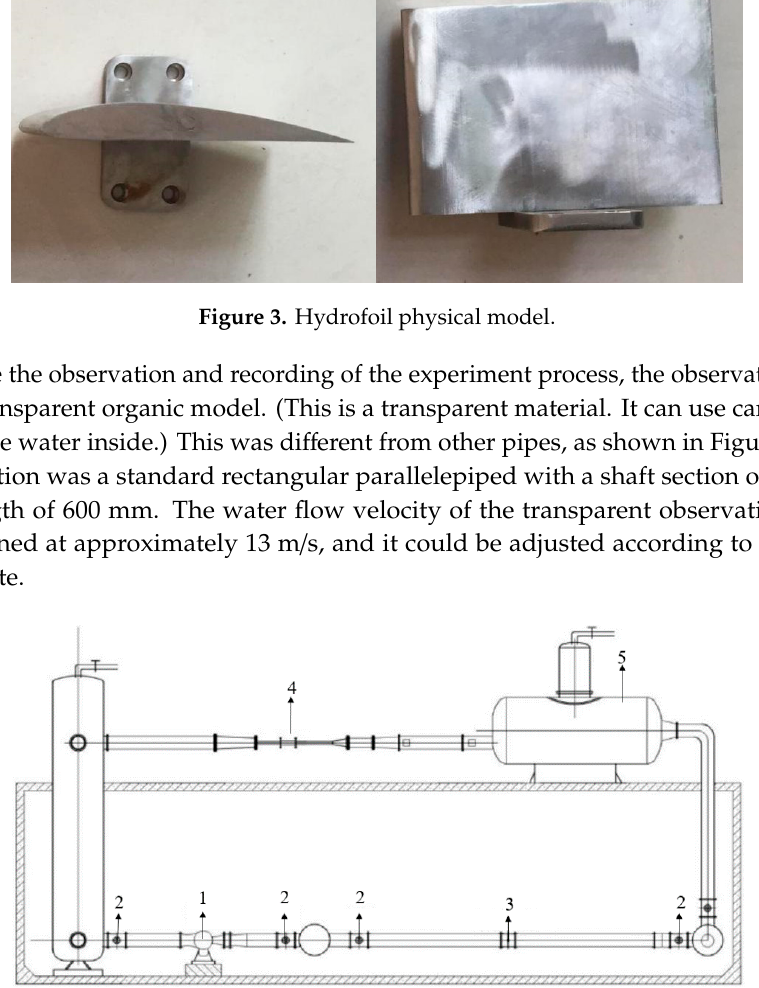
Figure 4. Schematic diagram of the experiment bench system. (1) Circulation pump, (2) gate, (3) electromagnetic flowmeter, (4) observation section, (5) vacuum tank.